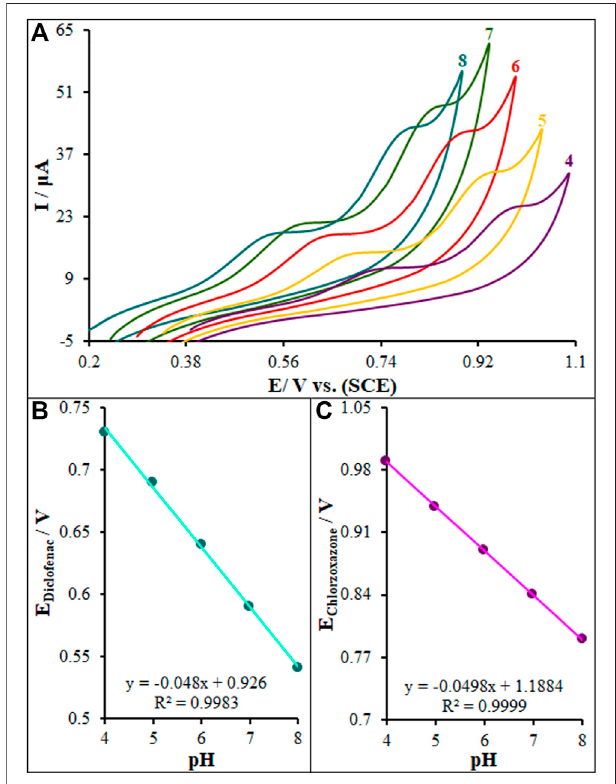
FIGURE 6 | (A) CVs of La 2 O 3 @SF-L Cu 2 S/GCE in the presence of 0.4 mM [Fe(CN)6] 3- solution in aqueous 0.1 M KCl at various scan rates (from inner to outer curve): 10, 20, 30, 40, 50, 60, 70, 80, 90, 100, 200, 300, 400, 500, 600, 700, 800, 900, and 1000 mV/s. (B) The plot of peak currents vs υ 1/2.